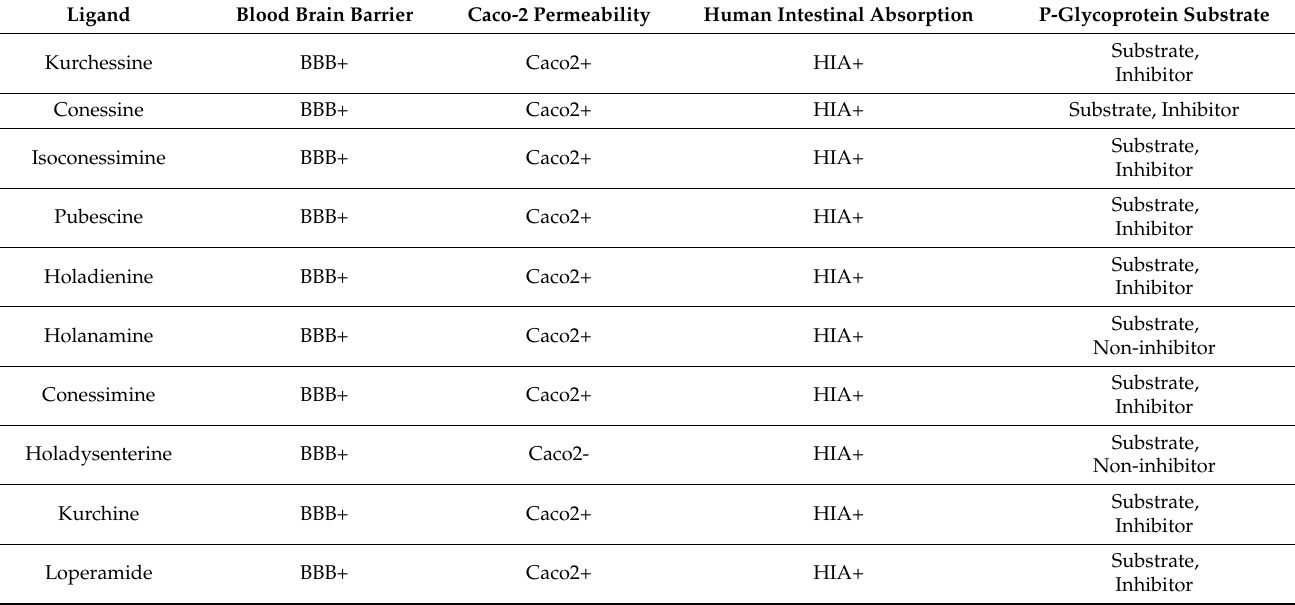
Table 4. ADMET Properties of the